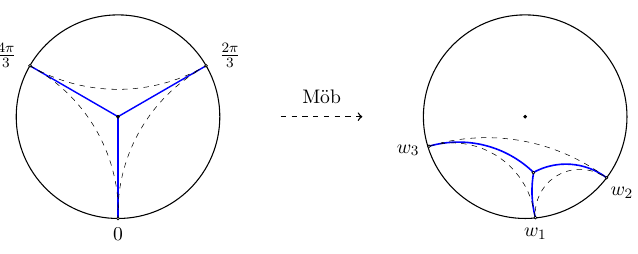
Figure 8 . The holographic ideal N = 3 Steiner tree (c) on (cid:12)gure 6 can be obtained by the M(cid:127)obius transformation from the graph with the FT point in the center of the disk. The weights are equal and the angles at both FT points are equal 120 (cid:14)